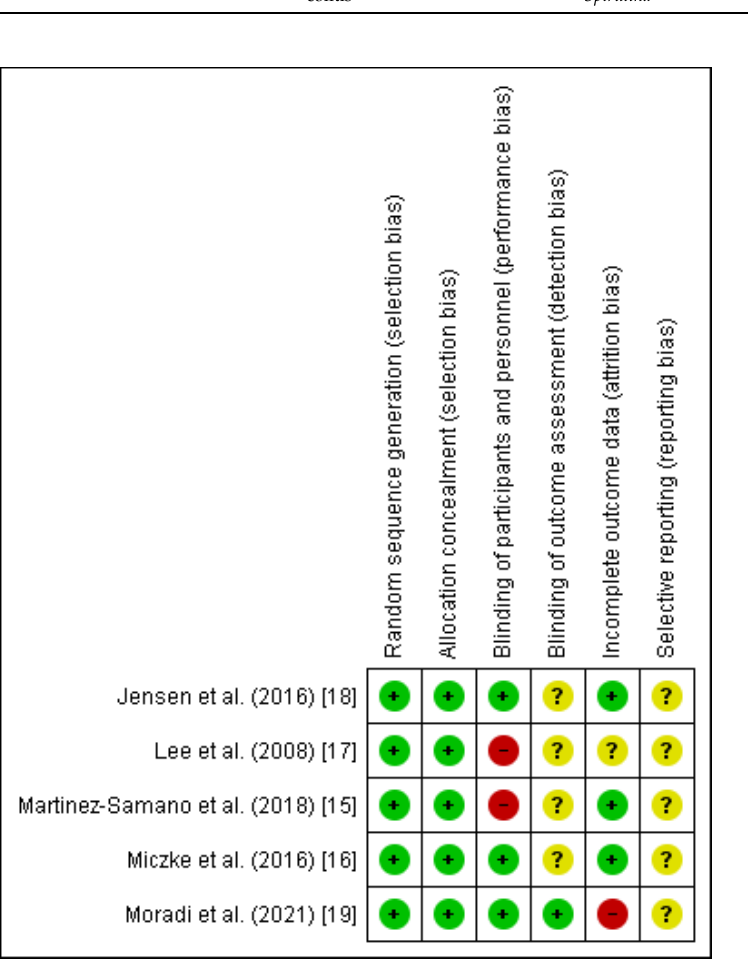
Figure 2. Risk of bias assessment for included randomized controlled trials (RCTs) [15–19].